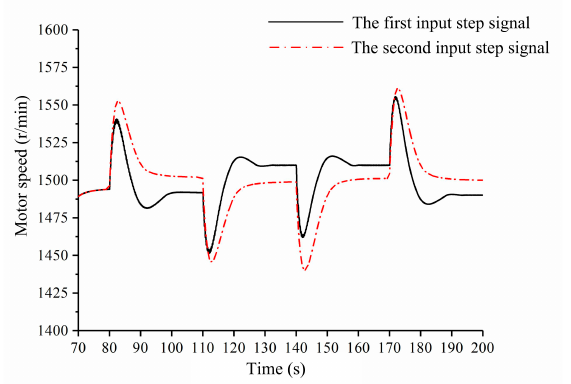
Figure 17. The closed loop motor speed curve.